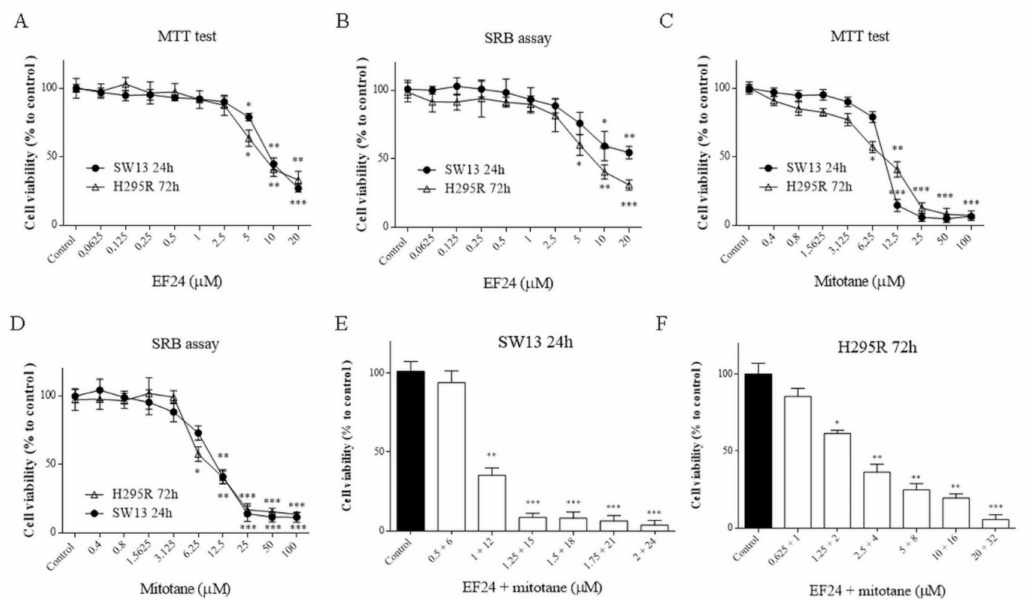
Figure 2. MTT and SRB assay for SW13 and H295R cells treated for 24 h and 72 h. ( A ) MTT test for EF24; ( B ) SRB assay for EF24; ( C ) MTT test for mitotane; ( D ) SRB assay for mitotane; ( E ) MTT test for combination index calculation in SW13 at 24 h; ( F ) MTT test for combination index calculation in H295R at 72 h. Di ff erent drug concentrations were used following a series of CI values generated by the CompuSyn 3.0.1 program. Experiments were performed in quadruplicate and repeated three times. Treatment vs. control: * p < 0.05, ** p < 0.01, *** p < 0.001.